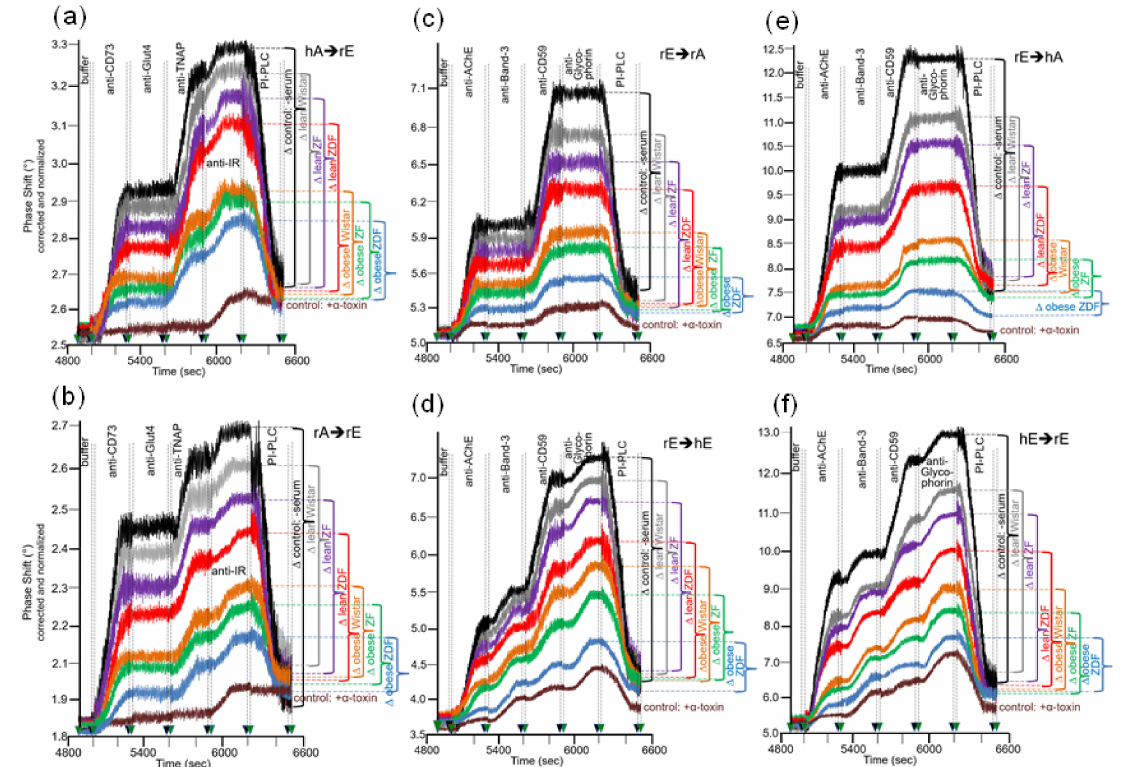
Figure 11. Determination of the effect of serum proteins from the six rat groups on the transfer of full-length GPI-APs from donor to acceptor PM at various combinations. The experiment was performed as described for Figure 6 with injection of 400 µ L of donor PM (800–1200 s) at a flow rate of 60 µ L/min and subsequent incubation (until 4800 s, 60 min, 37 ◦ C) of the donor–acceptor PM combinations (( a ), hA → rE; ( b ), rA → rE; ( c ), rE → rA; ( d ), rE → hE; ( e ), rE → hA; ( f ), hE → rE) in the absence (control: -serum) or presence of 100 µ L serum (diluted five-fold) from the six rat groups or in the presence of 10 µ g/mL α -toxin (control: + α -toxin) as indicated (donor PM → acceptor PM). At variance with Figure 6, the rat (r) donor and acceptor PM were derived from adipocytes (A) and erythrocytes (E) which had been isolated from obese ZDF rats. Phase shifts are shown only between start of buffer injection (4800 s) and termination of PI-PLC injection (6600 s). ∆ phase shifts as measure for GPI-AP transfer are calculated as described for Figure